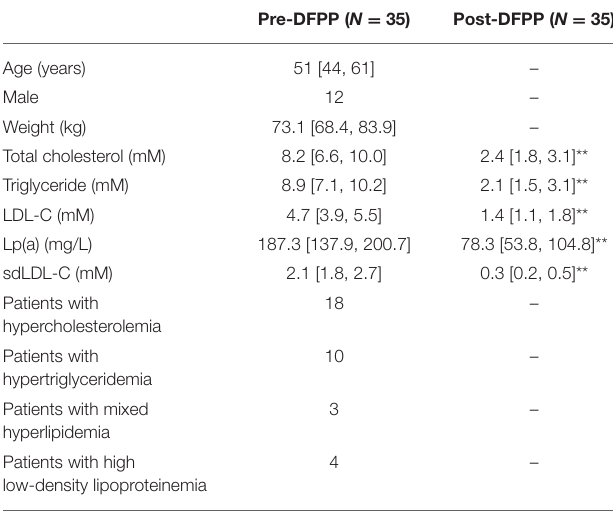
TABLE 1 | The variations of lipids before and after DFPP